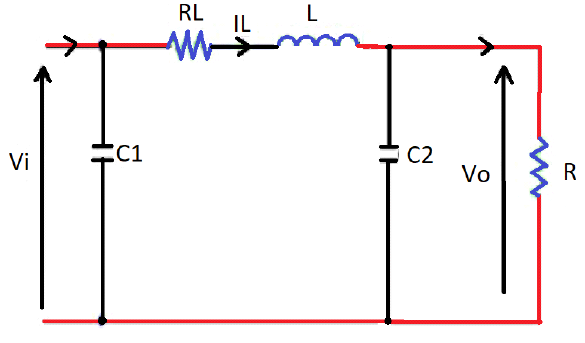
Figure 5. OFF state operation.